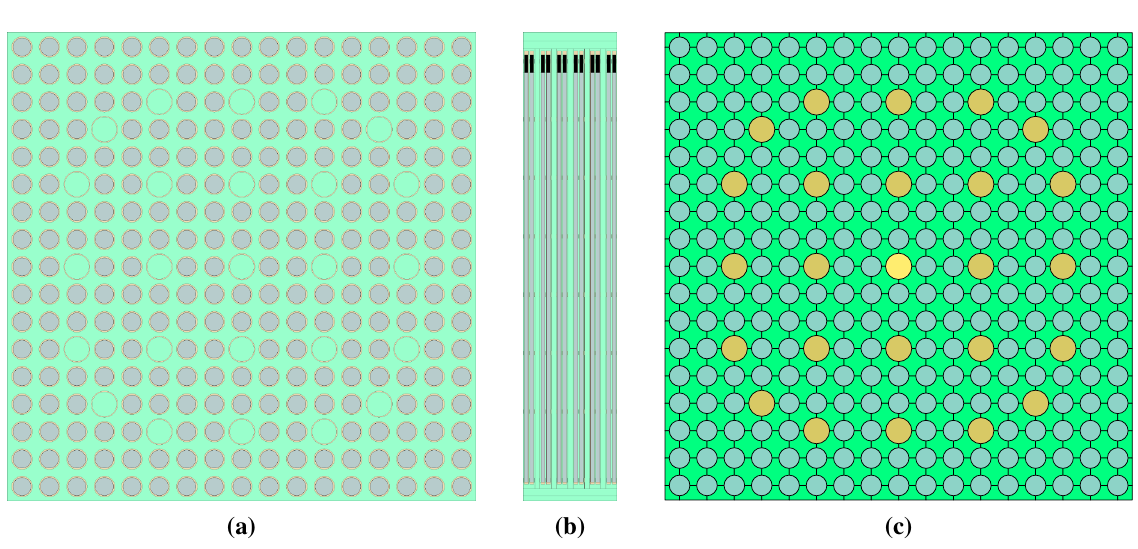
Figure 2: Serpent2 (left, center) and SCF (right)